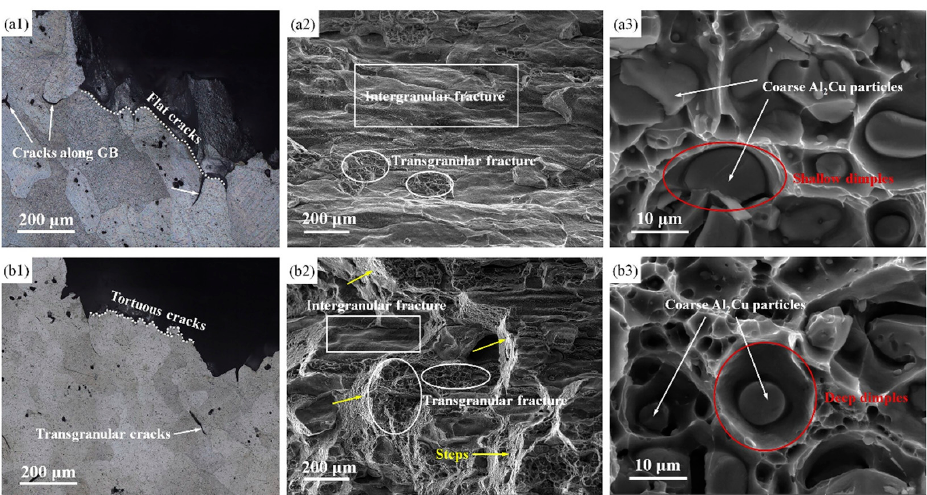
Figure 16. OM and SEM images of axial tensile fracture surfaces of 2219 aluminum alloys: ( a1 – a3 ) HC and ( b1 – b3 ) HC and CD processing [82].